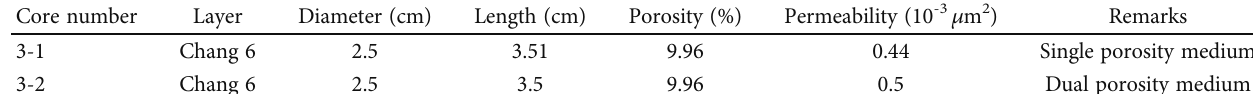
Table 1: Parameters of spontaneous imbibition experiment of cores.